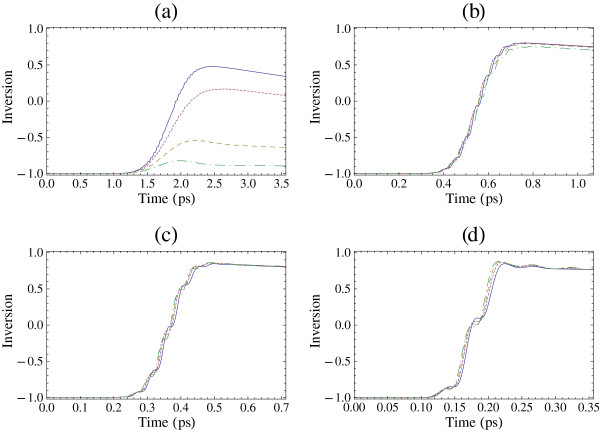
The time evolution of the inversion S3(t) for a Gaussian pulse. The excitation is on-resonance, i.e., ω = ω10, the pulse area is θ = Π, and φ=0. (a) np= 10, (b) np= 3, (c) np= 2, and (d) np= 1. Solid curve: N = 109cm−2, dotted curve: N = 3 × 1011cm−2, dashed curve: N = 5× 1011cm−2, and dot-dashed curve: N = 7 ×1011cm−2.